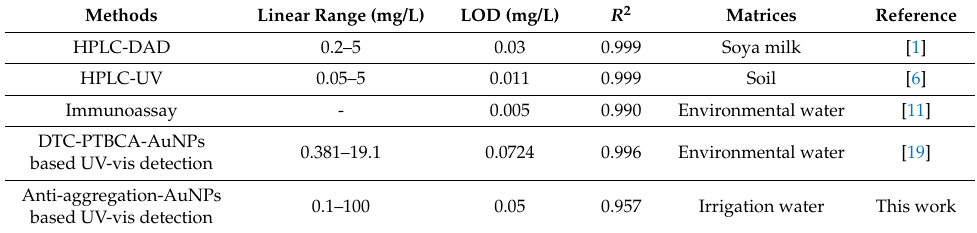
Table 1. Comparison of the linear ranges and detection limits of different methods.